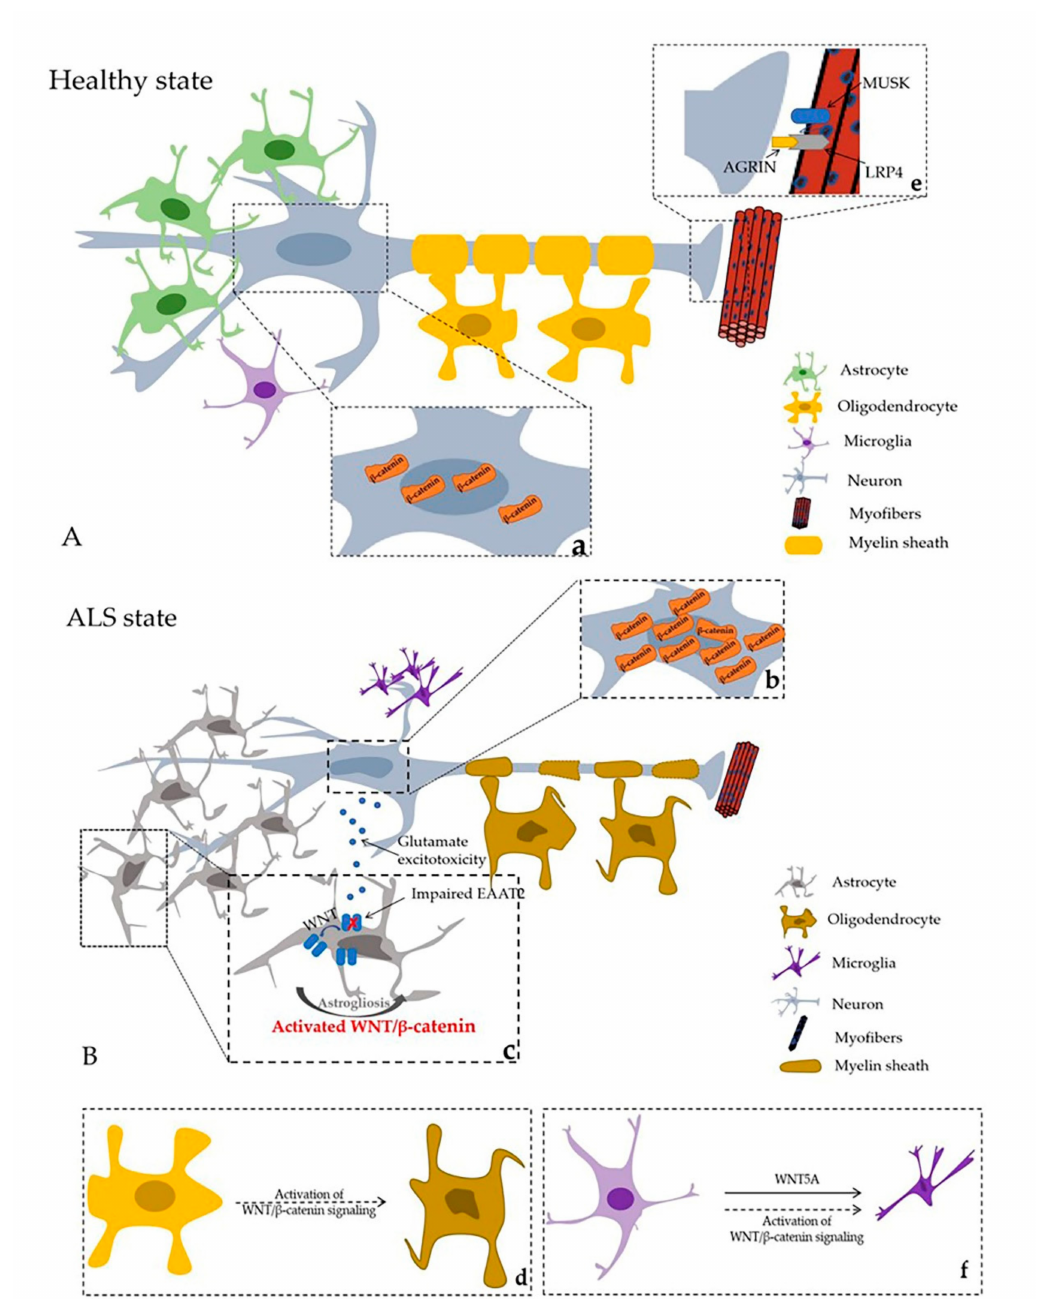
Figure 2. Healthy state and ALS state in central nervous system (CNS) and neuromuscular junction (NMJ). ( A ) Healthy state; ( B ) ALS state; a. and b represent β –catenin distribution in healthy and ALS states, respectively; a . Normal β –catenin distribution in motor neurons. b . Extensive β –catenin accumulates in the cytoplasm in the motor neuron cell model in vitro. β –catenin protein nucleus translocation can be observed in the later stage of ALS in SOD1–G93A mice. c . Astrogliosis and molecular and functional abnormalities of astrocytes in ALS. d . Axon damage and oligodendrocyte degeneration. e . AGRIN–LRP4–MUSK complex promote stability of postsynaptic differentiation. f . WNT signaling and proinflammatory of microglia (black arrows represent phenomena in ALS; dashed arrows illustrate hypothetical modes in